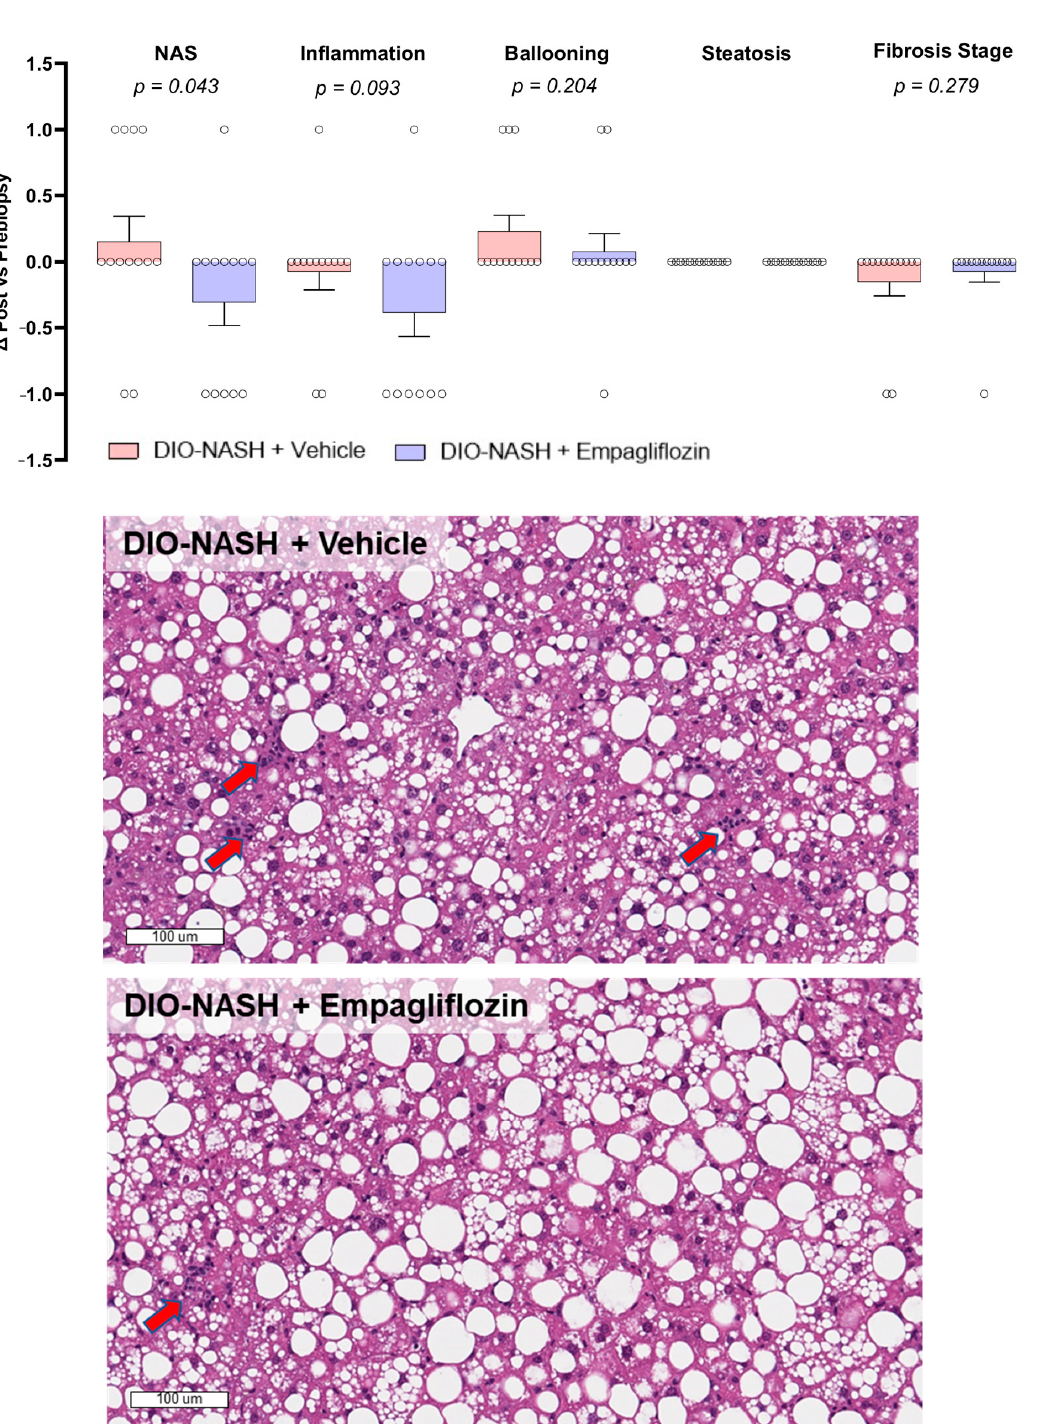
Figure 4. Empagliflozin improves liver histopathology. Histological changes in NAS, lobular inflammation, ballooning degeneration, steatosis and fibrosis stage in liver post- vs. pre-treatment biopsies. H&E staining for DIO-NASH mice treated with the vehicle or empagliflozin. Red arrows show inflammatory foci. Normal distribution was evaluated with a D’Agostino–Pearson test and an unpaired t -test was performed and one-tailed p -values are reported. Data show means ± SEMs. n = 13 for DIO-NASH + vehicle and DIO-NASH +